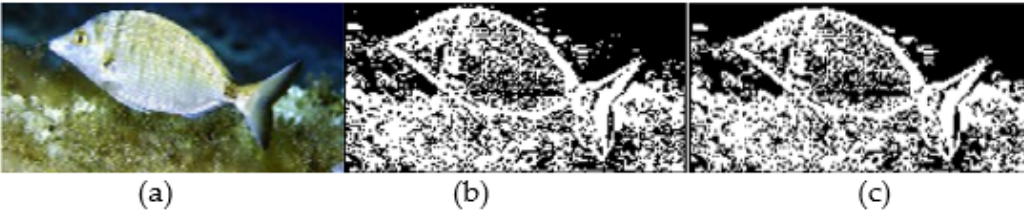
Figure 3. Original image ( a ), the edgesgm matrix after gradient edge detection ( b ) and the edgesegm matrix after edge reduction ( c ). The path “Contour1” is not acceptable, since 7 of its boundary segments were found to be crowded.